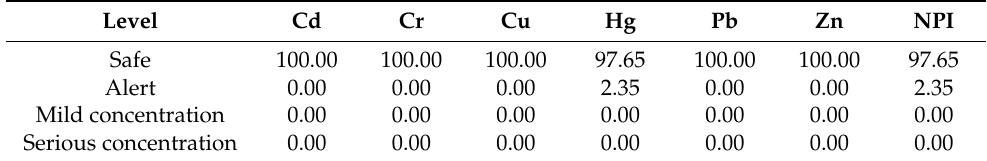
Figure 2. Results for the Pi index of six heavy metals in surface water of the study area. Table 4. Proportions (%) of Nemerow pollution index (NPI) levels of six heavy metals in surface